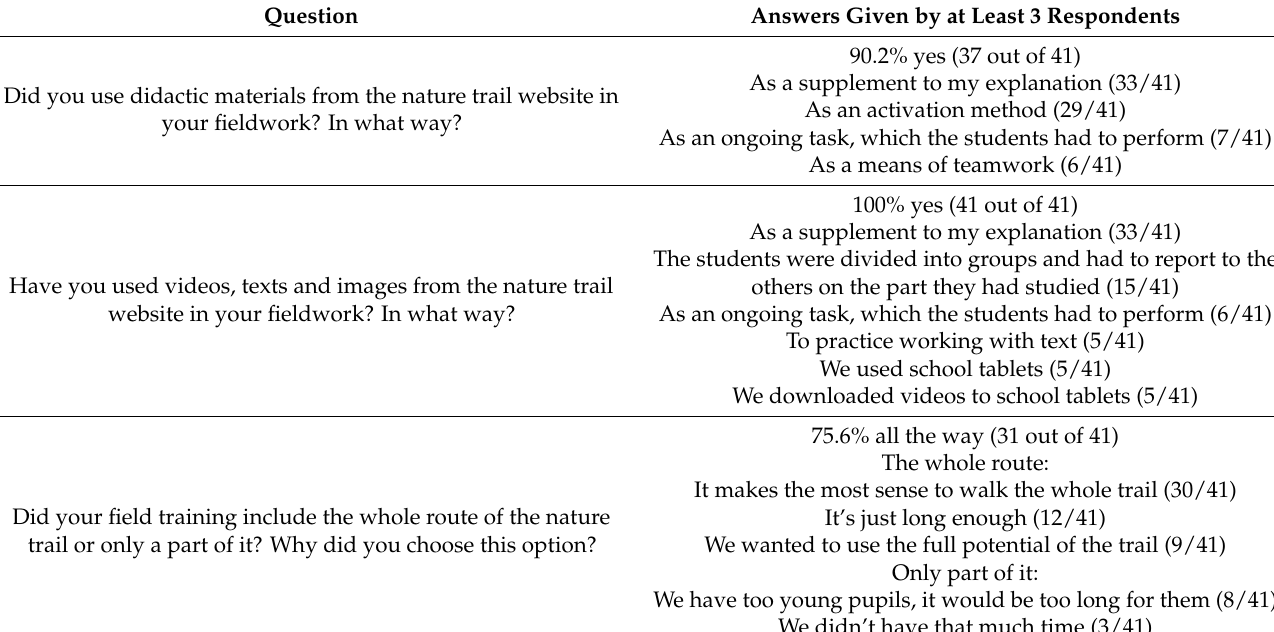
Table 1. Responses to the questions from the questionnaire regarding the chosen form of